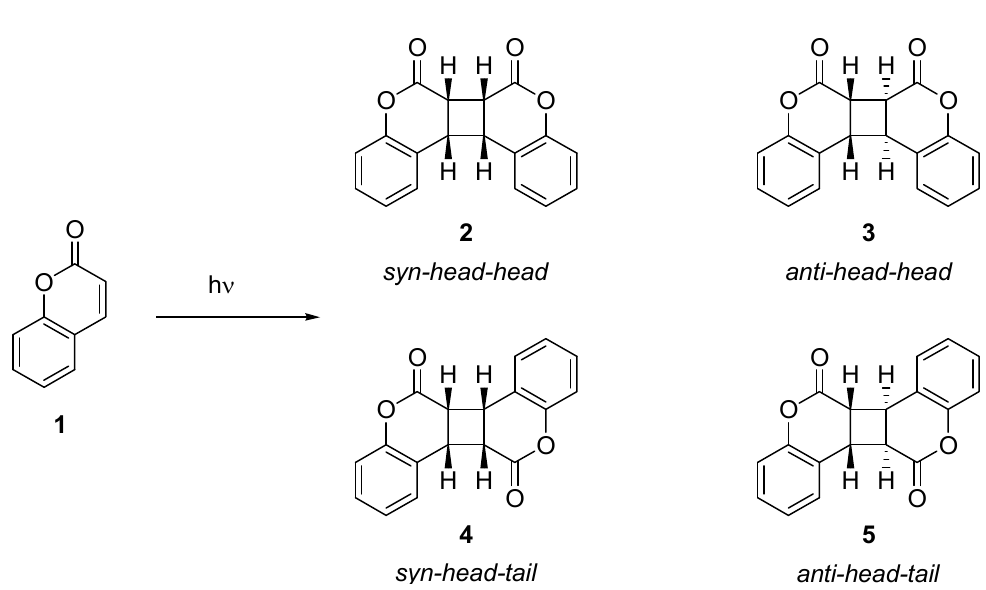
Scheme 1. Photodimerization of coumarin.